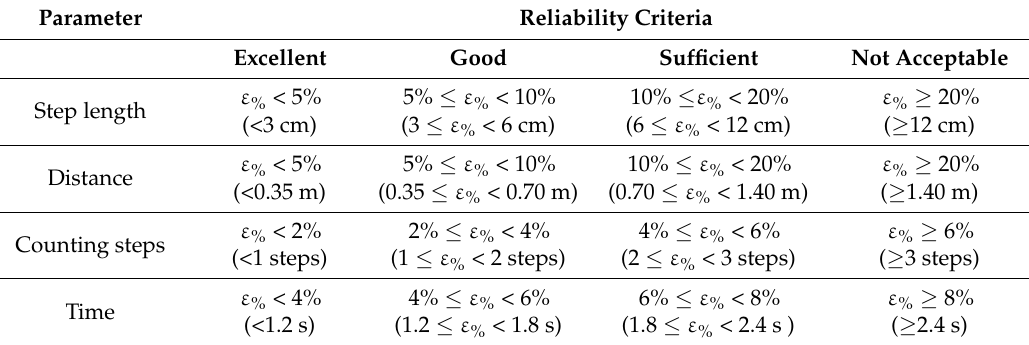
Table 2. Reliability assessment grid for the analysis of wearable IMUs for GA. ε % is the mean absolute percentage error in